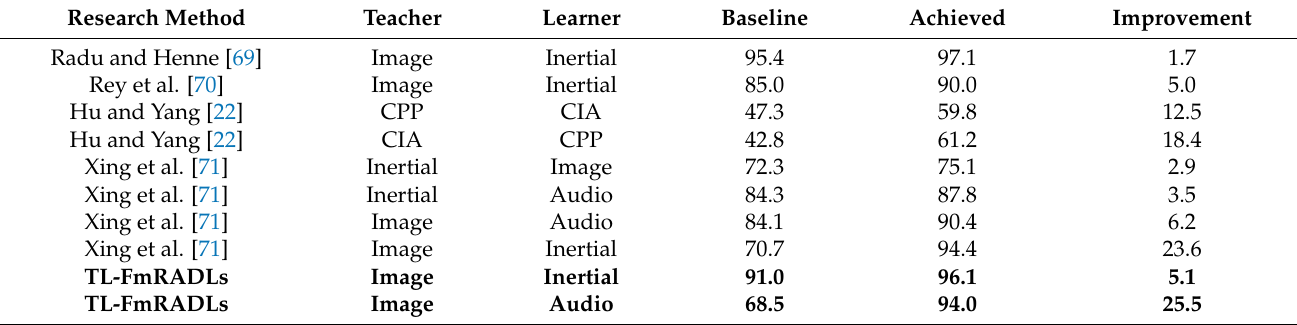
Table 13. Comparison of TL-FmRADLs’ performance against state-of-the-art approaches, where CPP stands for contact movement, passive infrared, pressure, and CIA stands for contact movement, image,